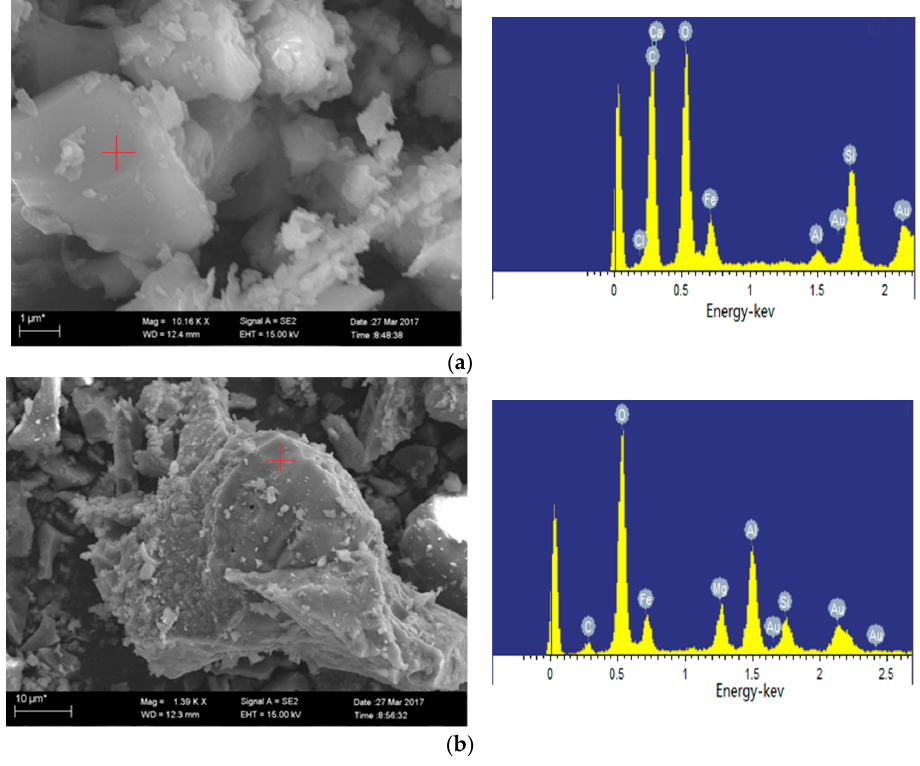
Figure 11. Minerals in oxidation ash of Ulanqab (SEM-EDS, secondary electron images). ( a ) Hercynite (1100 °C); ( b ) iron-bearing minerals and calcium feldspar co-melt at 1200 °C.